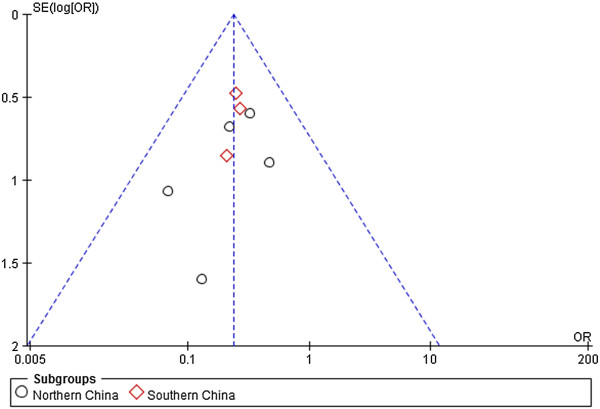
The funnel plot of complication incidence.